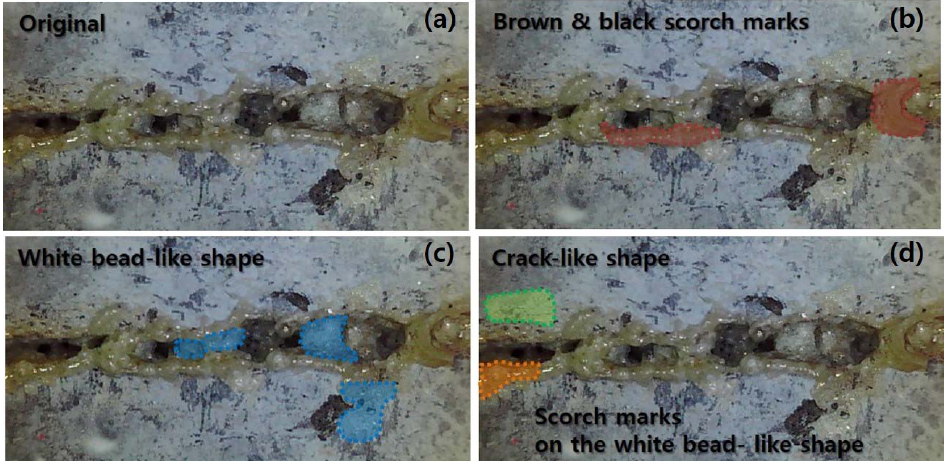
Figure 13. Three characteristics on the surface of the processed LU series: ( a ) no processed region; ( b ) brown and black scorch mark (Red); ( c ) white bead ‐ like shape (Blue); ( d ) crack ‐ like shape (Green), and scorch marks on the white bead ‐ like shape (Orange).